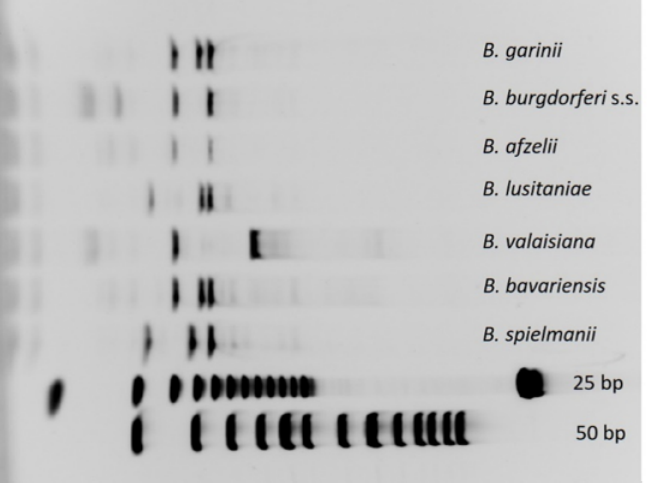
Figure 1. RFLP patterns of the defined Borrelia species used as positive controls for the species differentiation in tick samples.